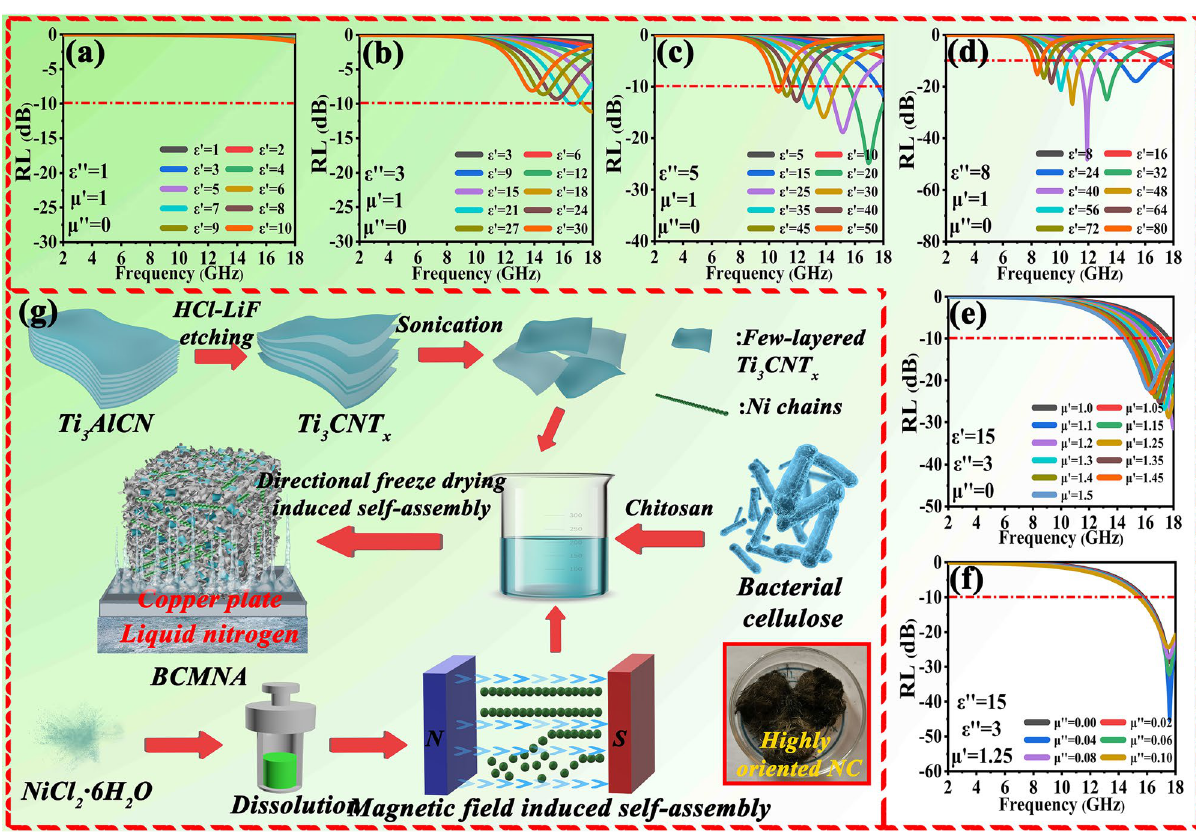
Fig. 1 a – f Deductive calculation of reflection loss under 1 mm thickness; g schematic illustration for the fabrication of